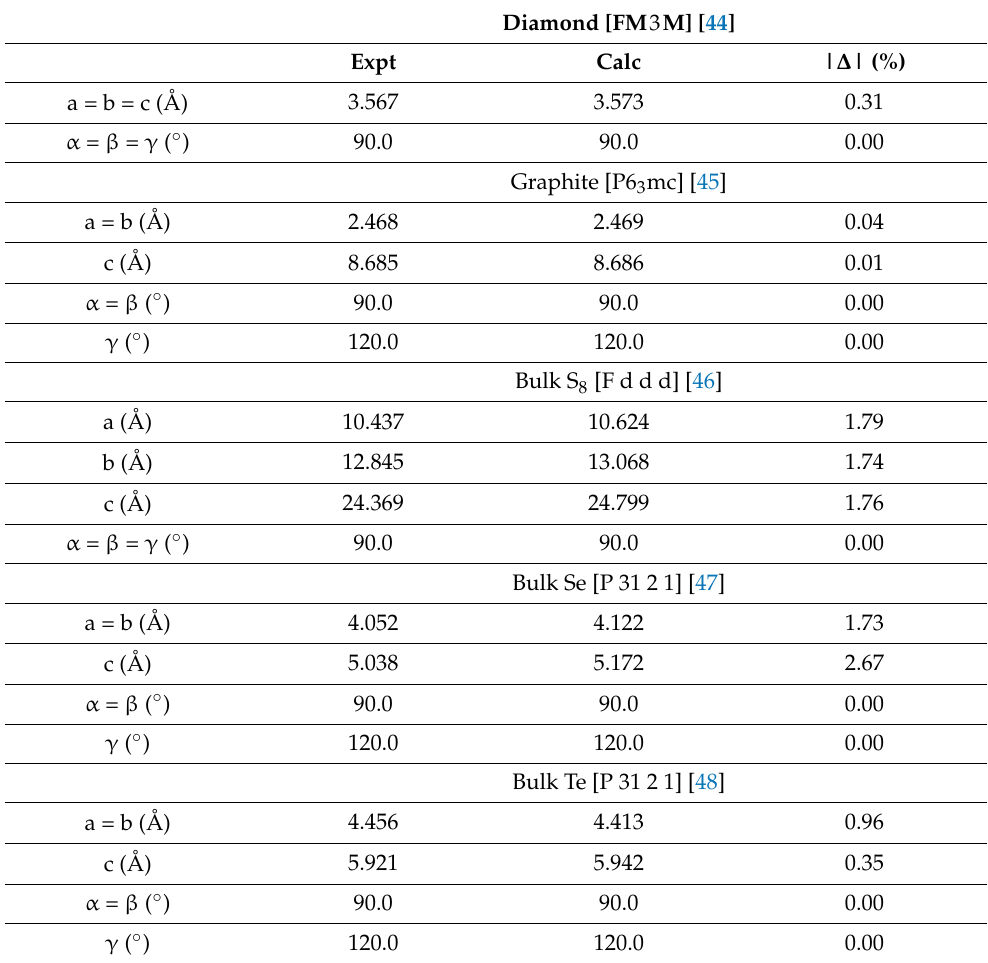
Table 1. Calculated and experimental lattice parameters of diamond, graphite, bulk S 8 , bulk Se and bulk Te.